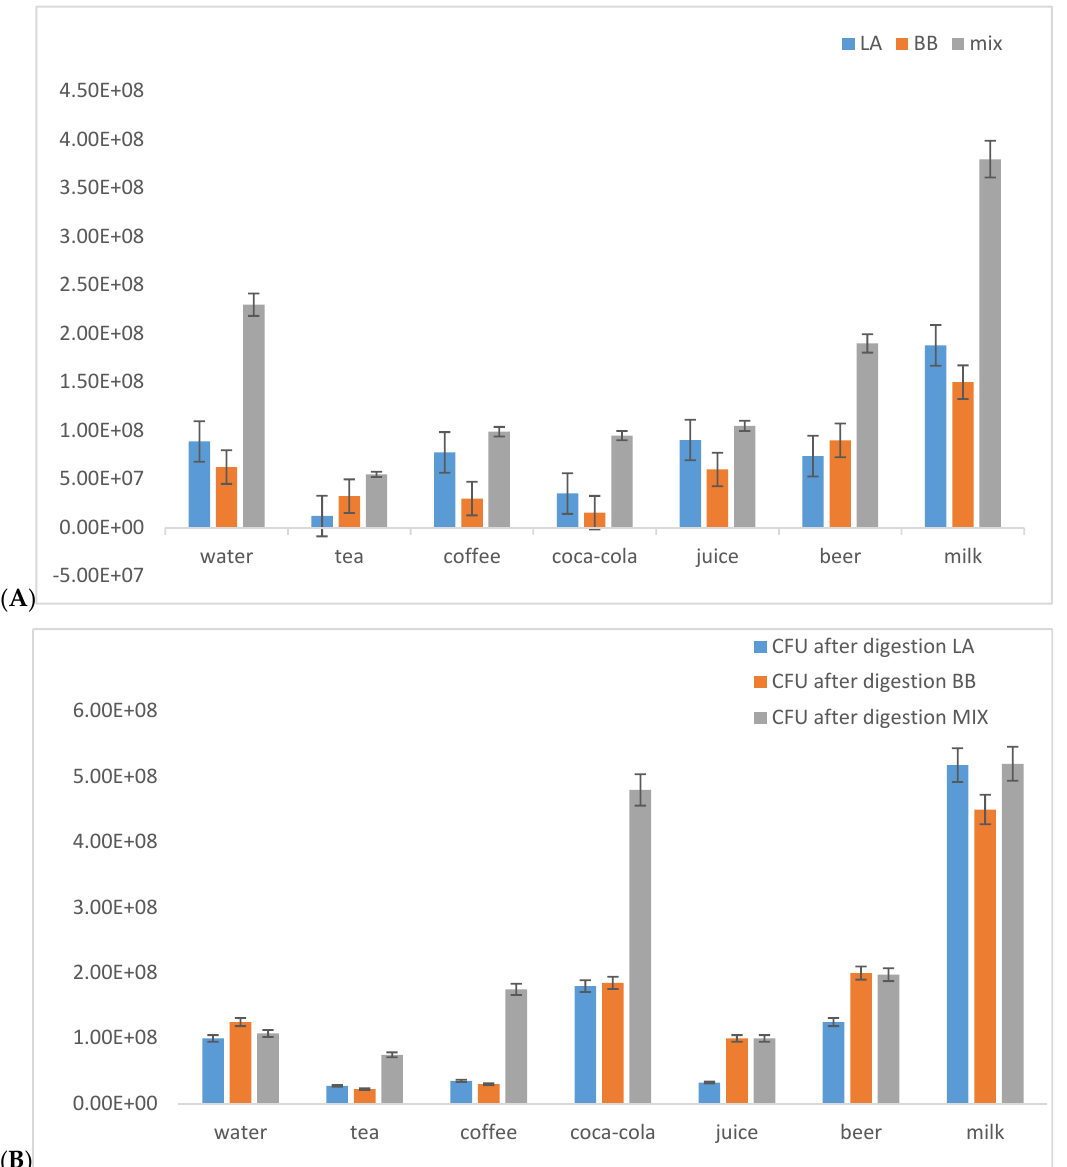
Figure 5. The influence of different types beverages and the type of probiotic on the number of viable cells after model digestion: comparison of monocultures Lactobacillus acidophilus (LA) and Bifidobacterium breve (BB) and mixed probiotic culture (MIX). ( A ) Viability after 15 min of incubation, and ( B ) viability after complete model digestion (2 h).